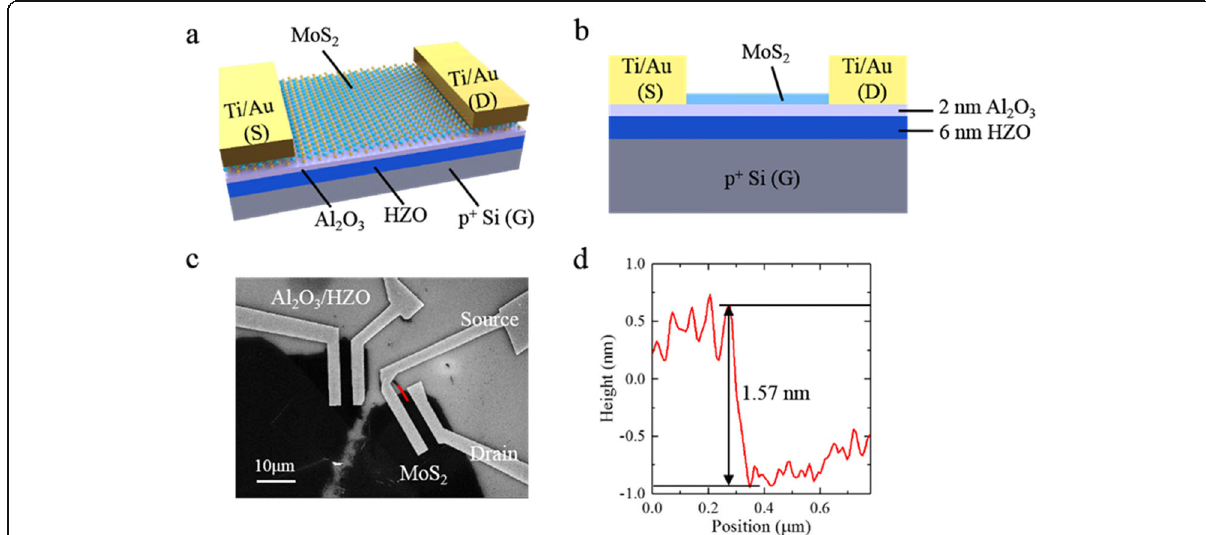
Fig. 1 Device structure and basic properties of the MoS 2 /HZO FeFET. a Three-dimensional schematic representation of the MoS 2 /HZO FeFET. b Schematic cross section of the MoS 2 /HZO FeFET. c Top-view SEM image of the fabricated MoS 2 /HZO FeFET with Ti/Au source/drain electrodes, HZO ferroelectric gate insulators, and MoS 2 channels. d Height profile using contact-mode AFM along the red line in c , validating the height of the MoS 2